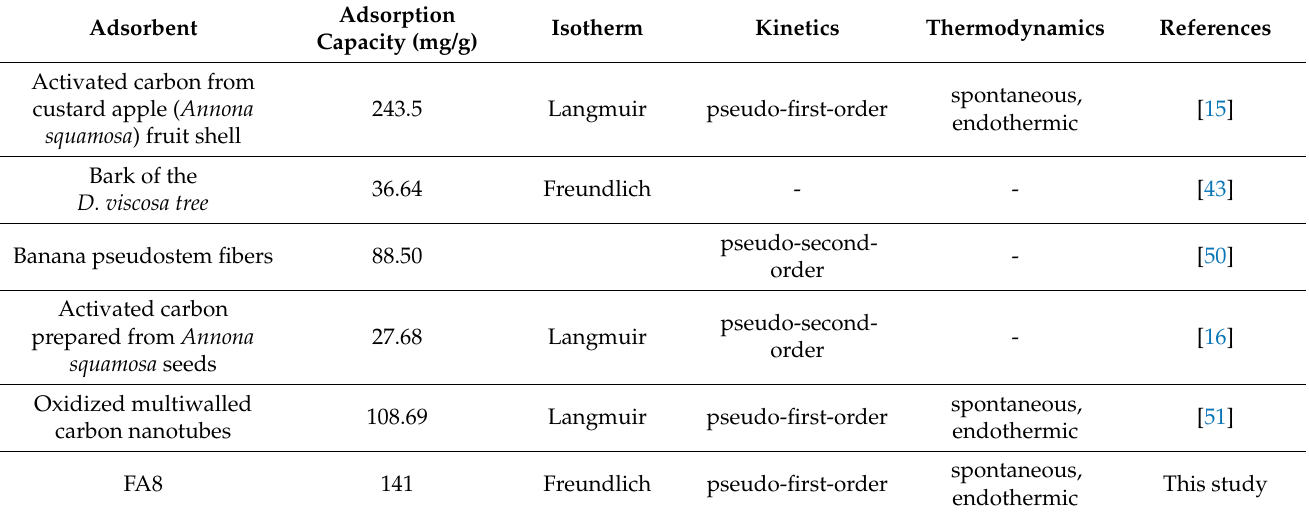
Table 7. Comparison of adsorption capacity with various reported adsorbents for methyl red